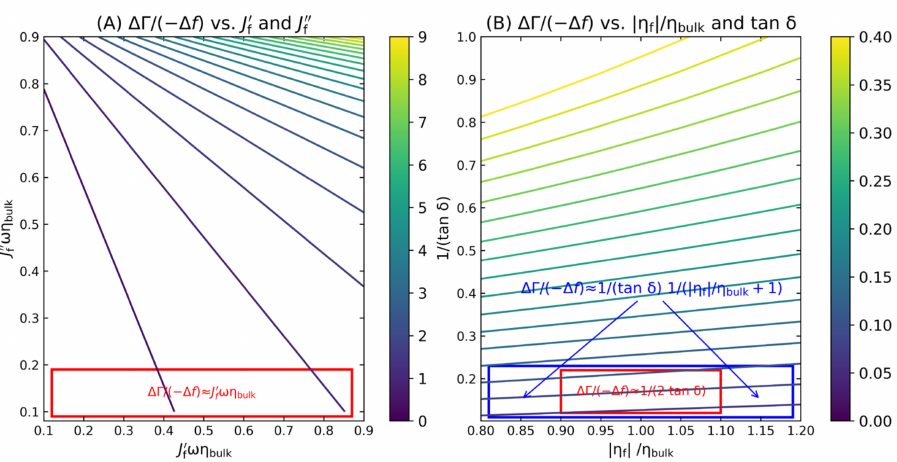
Figure 8. Contour plots of the acoustic ratio versus the viscoelastic parameters. Combinations of values on the contour lines all lead to the same acoustic ratio. The bars indicate the regimes, in which the assumptions underlying Equation (12) ( A ) and Equation (19) ( B ) apply.